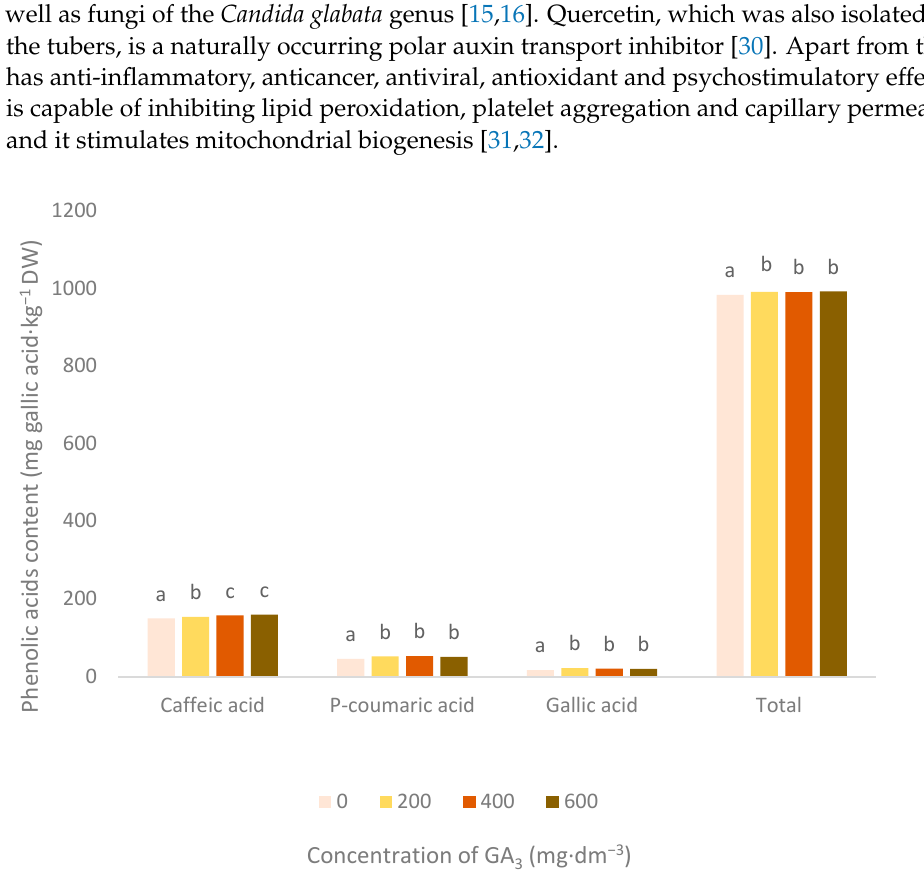
Figure 2. Phenolic acids content of the Crocosmia × crocosmiiflora ‘Lucifer’ tubers after application of GA 3 . Means followed by the same letter do not differ significantly at α = 0.05.